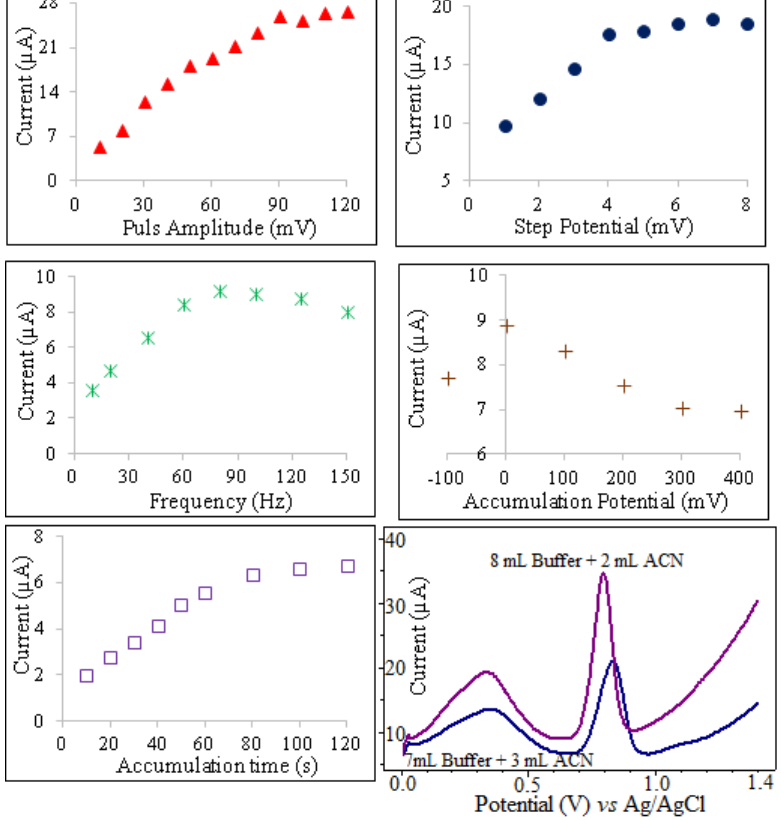
Figure 5. The e ff ects of experimental parameters on the SWSV determination of 3 mg / L oxyclozanide Figure 5. The effects of experimental parameters on the SWSV determination of 3 mg/L oxyclozanide in pH 2.0 BR bu ff er in pH 2.0 BR buffer solution.